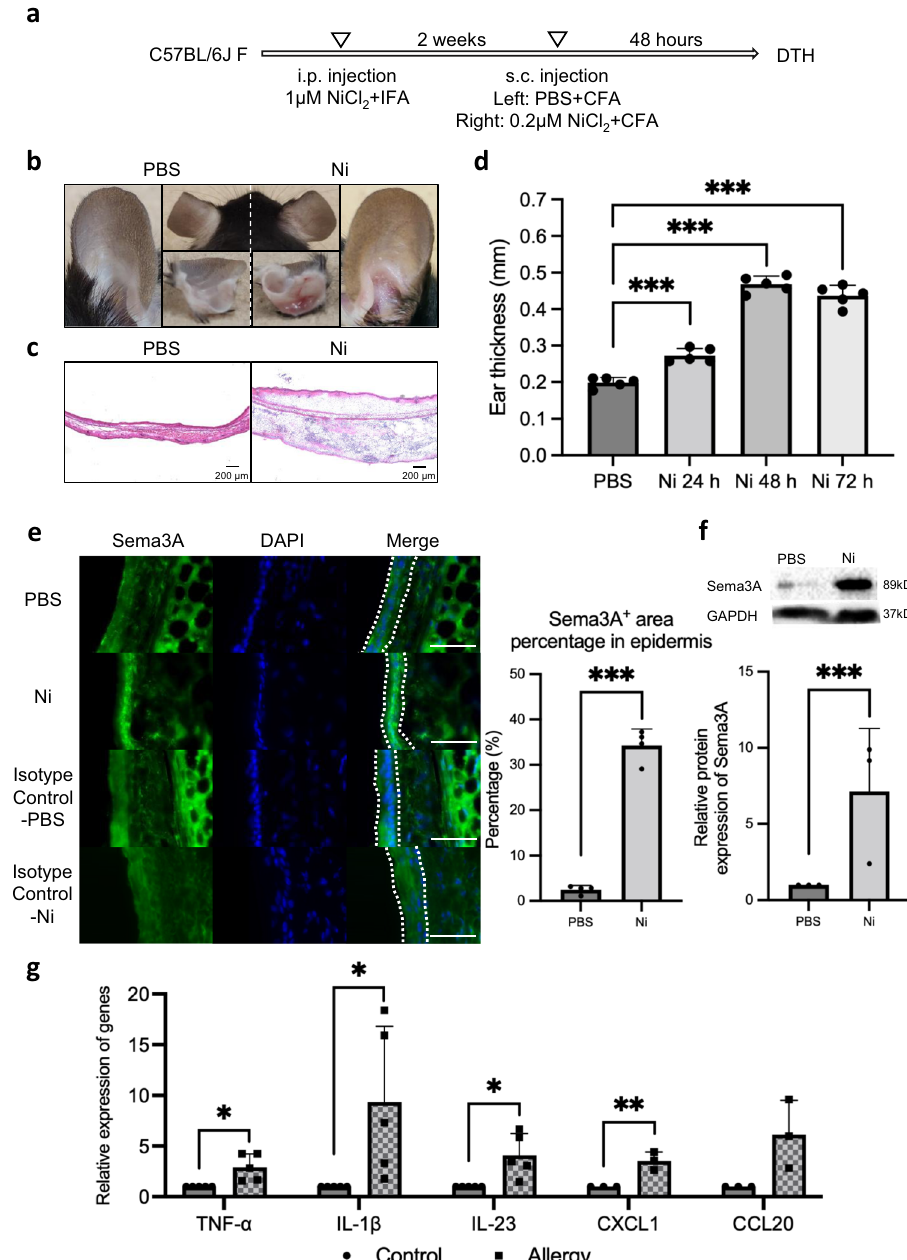
Fig. 3 Sema3A expression is upregulated in the Ni allergy site. a Protocol for inducing Ni allergy in mouse ear tissue. b Representative photos of the Ni allergy-induced mouse ear and the control ear. Photos show the ventral side (right and left), dorsal side (middle-upper), and cross-section (middle lower). c Histological images of Ni allergy-induced mouse ear tissue and control ear tissue. Scale bar, 200 µ m. d DTH was determined by measuring ear thickness after Ni re-challenge. Data are shown as mean ± SD of 5 mice/group. e Sema3A expression in the control and Ni allergy-induced ear tissue stained via an immuno fl uorescence assay. Staining with only anti-rabbit Fluor Alexa 488 secondary antibody was set as isotype controls for both PBS control group and Ni-challenged group. Dashed line shows the epidermis zone. Scale bar, 50 µ m. The percentage of the Sema3A-positive area (4 images/group) in the total area of epidermis in the ear tissue was analyzed using the BZ-X800 Analyzer software. f Upregulated Sema3A expression in Ni allergy-induced mouse ear tissue analyzed by western blotting analysis. GAPDH was used as the internal control. N = 3. The uncropped Western blotting image is shown in Supplementary Fig. 5c. g The mRNA expression of in fl ammatory cytokine/chemokine in Ni allergy-induced C57BL/6J mouse ear tissue analyzed using quantitative RT-PCR. Gene expression was normalized to levels of β -actin. N = 5. Data are shown as mean ± SD and are representative of at least three independent experiments. * p < 0.05, ** p < 0.01, *** p < 0.001; Two independent samples t -test. Supplementary Data and p values are provided as a Supplementary Data fi